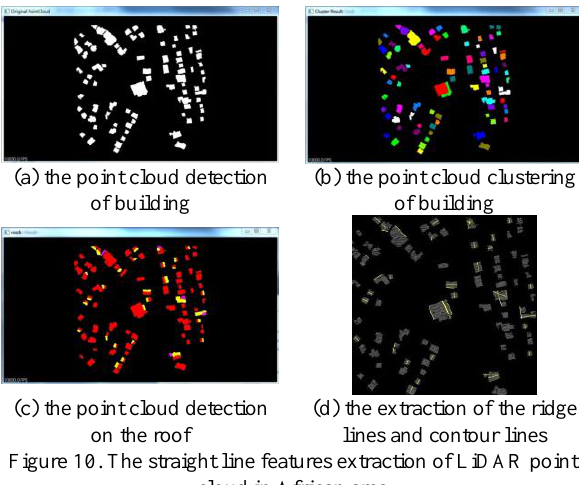
Figure 10. The straight line features extraction of LiDAR point